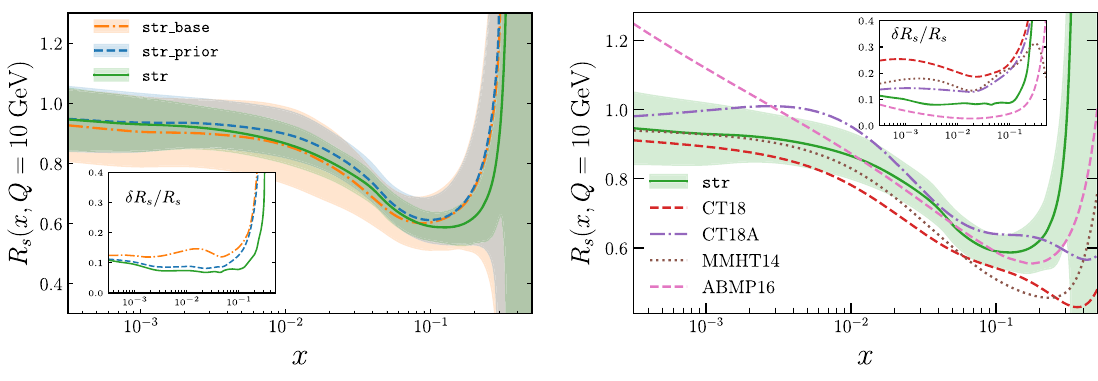
Fig. 8 The ratio R s , Eq. (3.1), as a function of x at Q = 10 GeV. The PDF used are from the str_base , str_prior and str fits (left), and from the str fit and from recent parton sets (right) see text for details. The insets display the corresponding relative uncertainty δ R s / R s